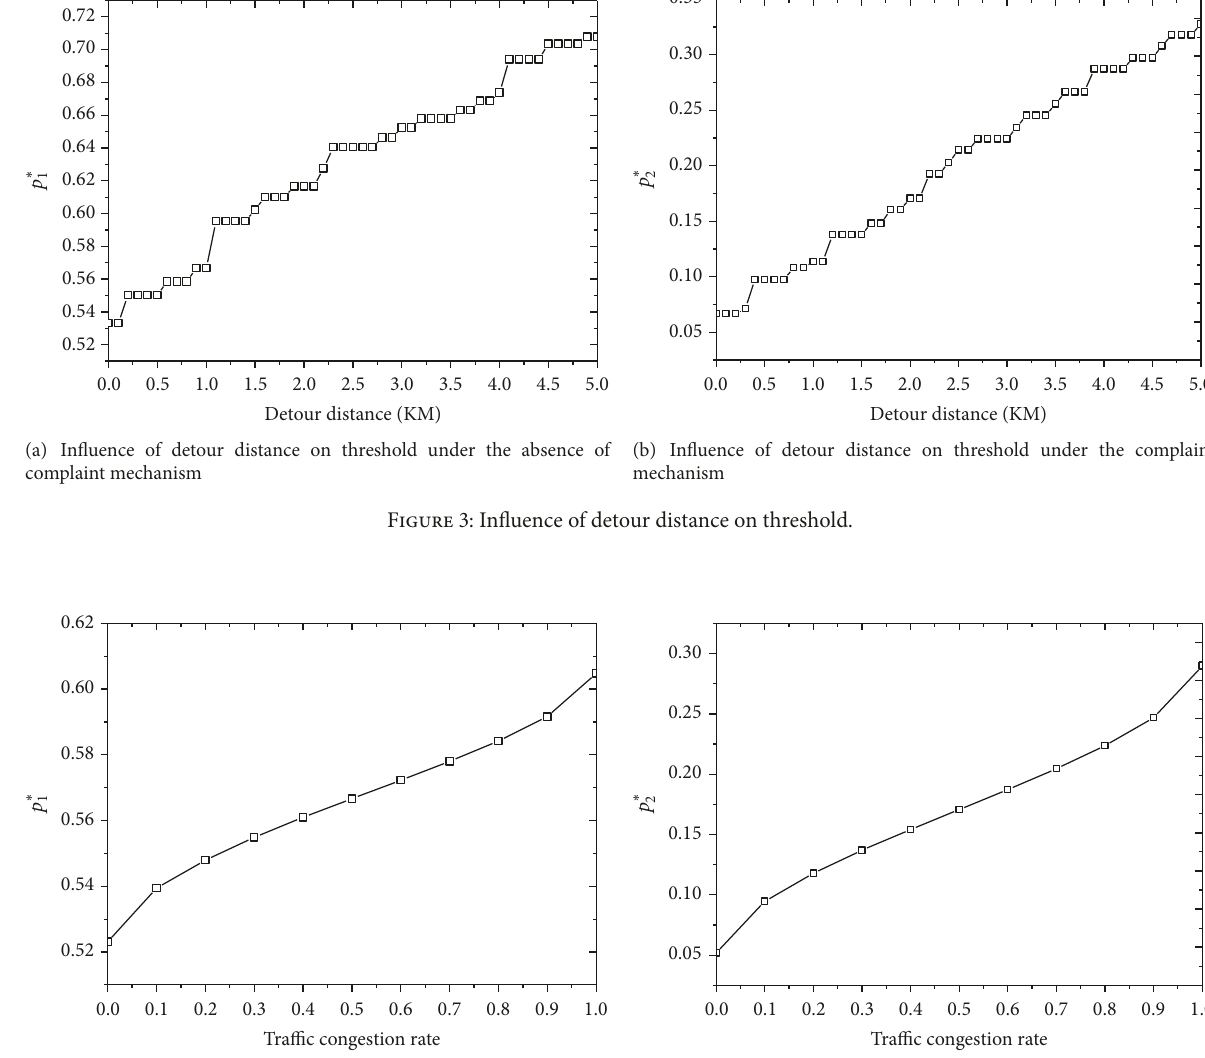
Figure 4: Influence of traffic congestion rate on